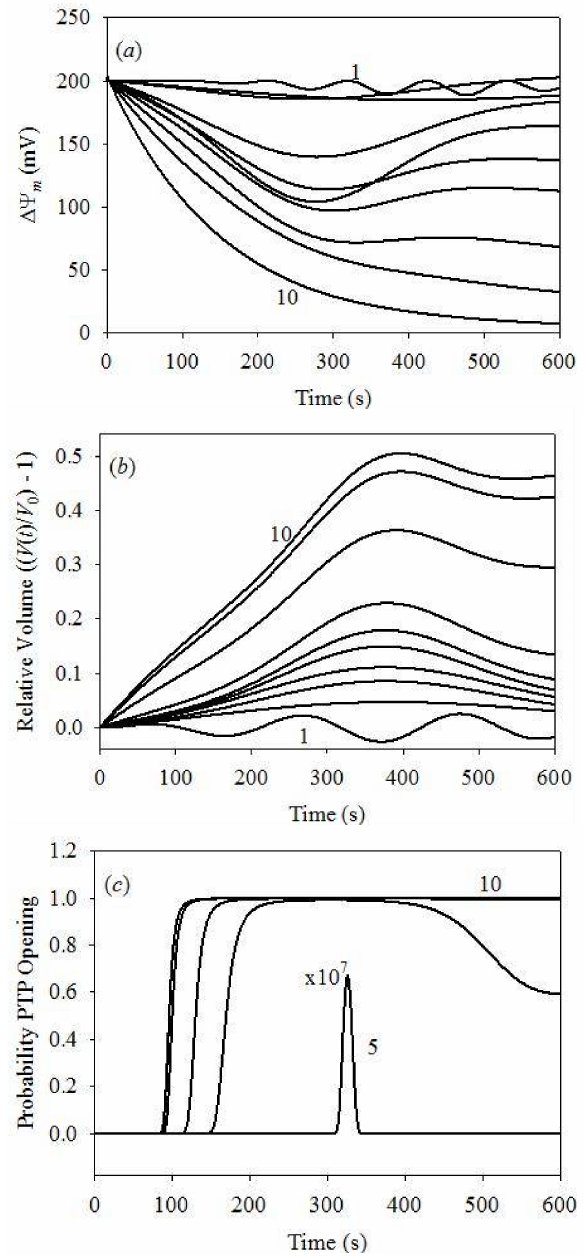
Figure 5. Dynamics of the IMM potential, mitochondrial volume and PTP opening probability for different initial cytosolic [Ca 2+ ] at fixed initial cytosolic [K + ] = 0.1 µ M. ( a ) IMM potential dynamics: plots 1–10 for [Ca 2+ ] = 1–500 µ M; ( b ) the V ( t )/ V 0 –1 value at different cytosolic [Ca 2+ ]: plots 1–10 for [Ca 2+ ] = 1–500 µ M; ( c ) dynamics of PTP opening probability: plot 5 for [Ca 2+ ] = 100 µ M is expanded by 10 7 ; plots 6 to 10: [Ca 2+ ] = 150–500 µ M, respectively. P PTP = 0 at all times for [Ca 2+ ] = 1, 25, 50 and 75 µ